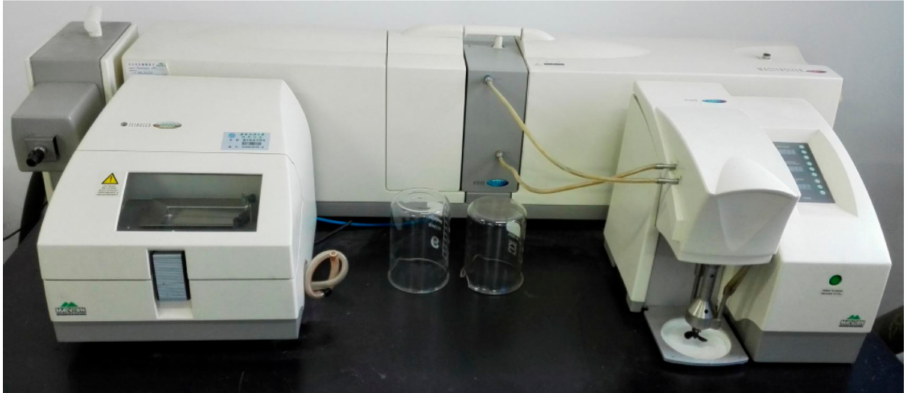
Figure 2. Master Sizer 2000 laser particle-size